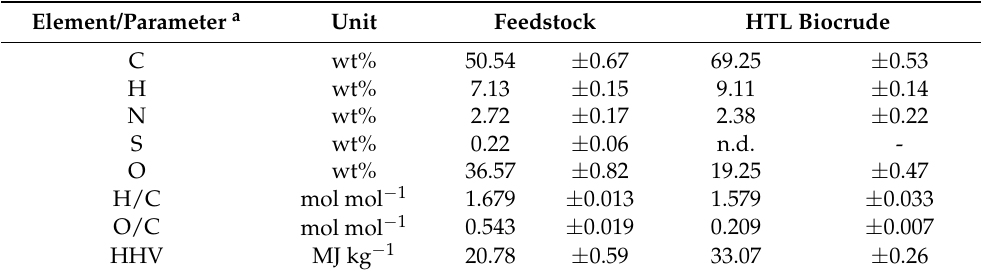
Table 1. Elemental composition of blackcurrant pomace as feedstock and biocrude obtained via its hydrothermal liquefaction in mixed solvents. Element/Parameter a Unit Feedstock HTL Biocrude